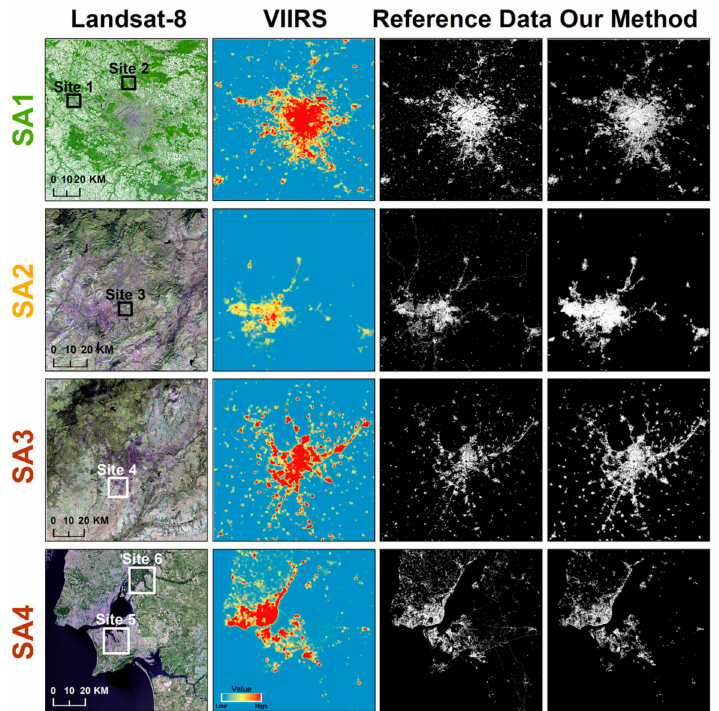
Figure 3. Results of the extraction of built-up areas according to di ff erent methods. For the reference data and our method, white pixels correspond to the built-up area while black pixels represent non-built-up